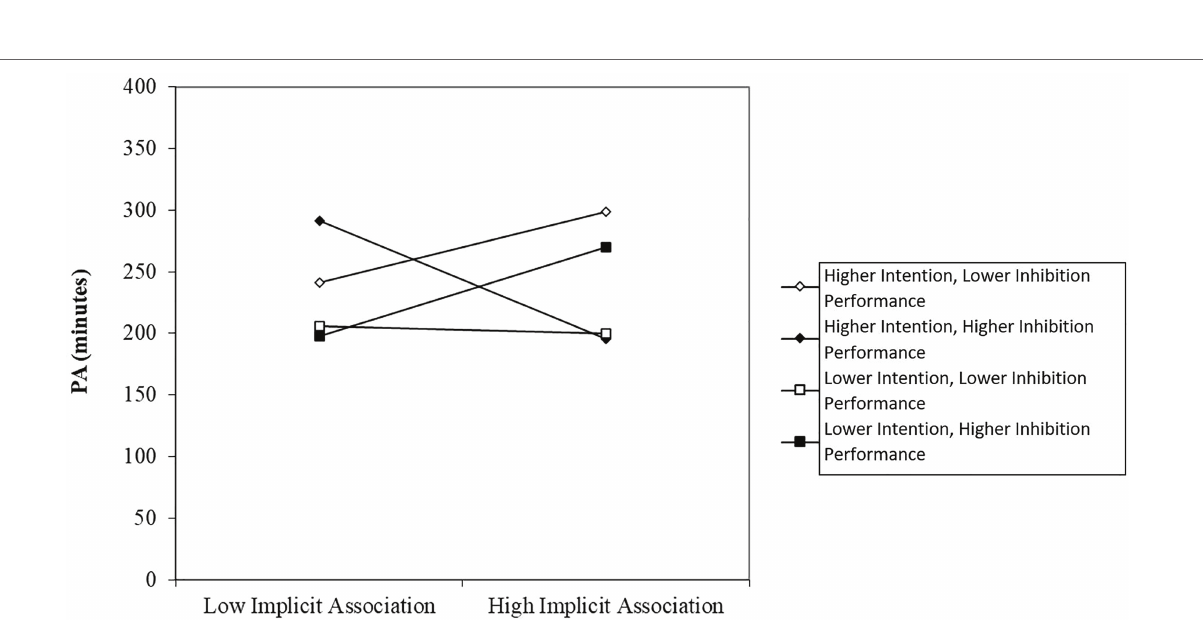
FIGURE 3 | Three-way interaction effect IAT x Intention x Inhibition on PA. Note that higher inhibition performance is referred to lower inhibition costs, while lower inhibition performance is referred to higher inhibition costs. PA (minutes) = physical activity in minutes at